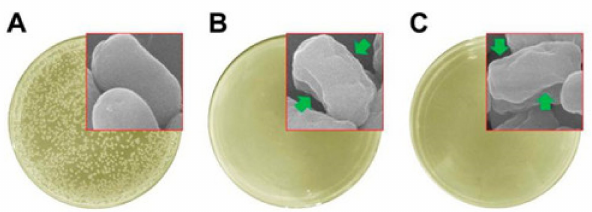
Figure 6. Photographs for the bacterial culture plates of E. coli upon a 120 min exposure of ( A ) the control, ( B ) PMMA–DCDMH, and ( C ) PMMA–DBDMH. Reprinted with permission from ref. [78]. Copyright 2016 ACS.